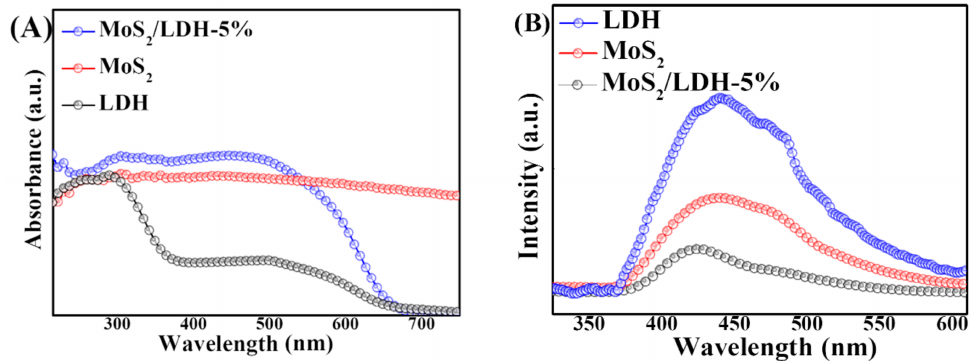
Figure 4. UV-Vis diffuse reflectance spectra ( A ) and PL spectra ( B ) of LDH, MoS 2 and MoS 2